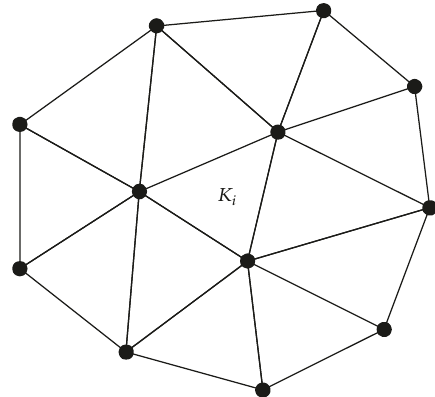
Figure 1: Example of the Finite Element triangulation of the domain 𝐵 0 .